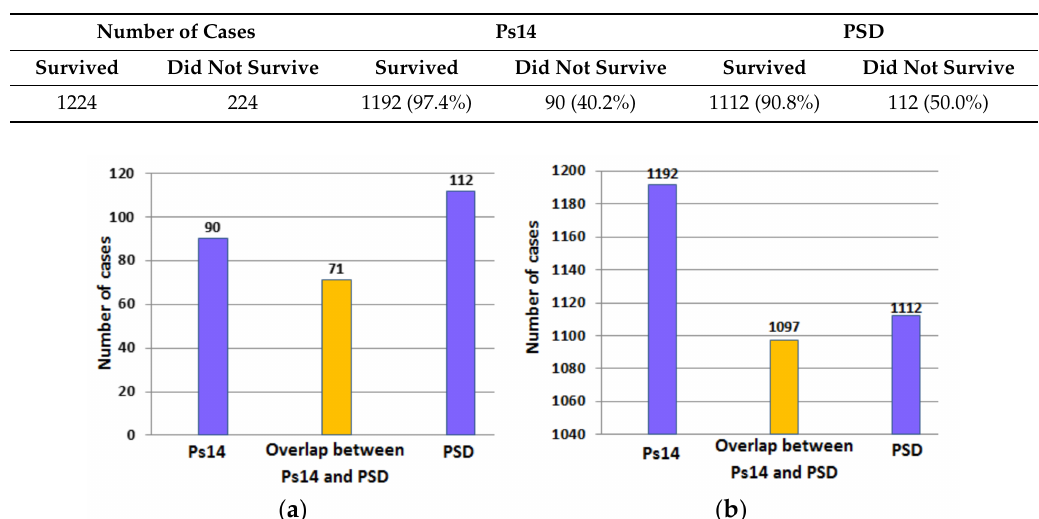
Table 7. Comparison of PSD and Ps14 to predict probability of survival for cases in the validation dataset (when probability value was greater than or equal to 0.5, the subject was classed as surviving and when probability value was less than 0.5, the subject was classed as not surviving).